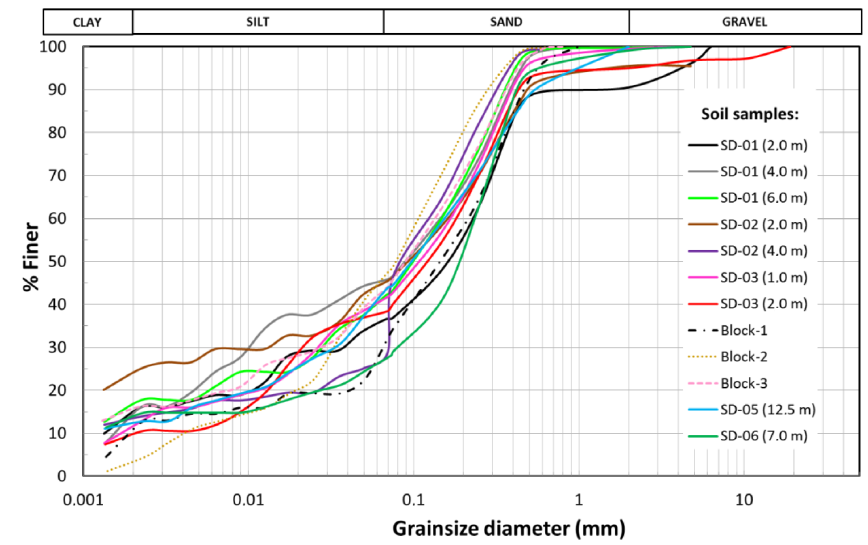
Figure 7. Granulometric distribution for the residual soil and the saprolite of the six boreholes analysed (SD-01 to SD-06) and for the undisturbed soil cores (Block 1 to Block 3).